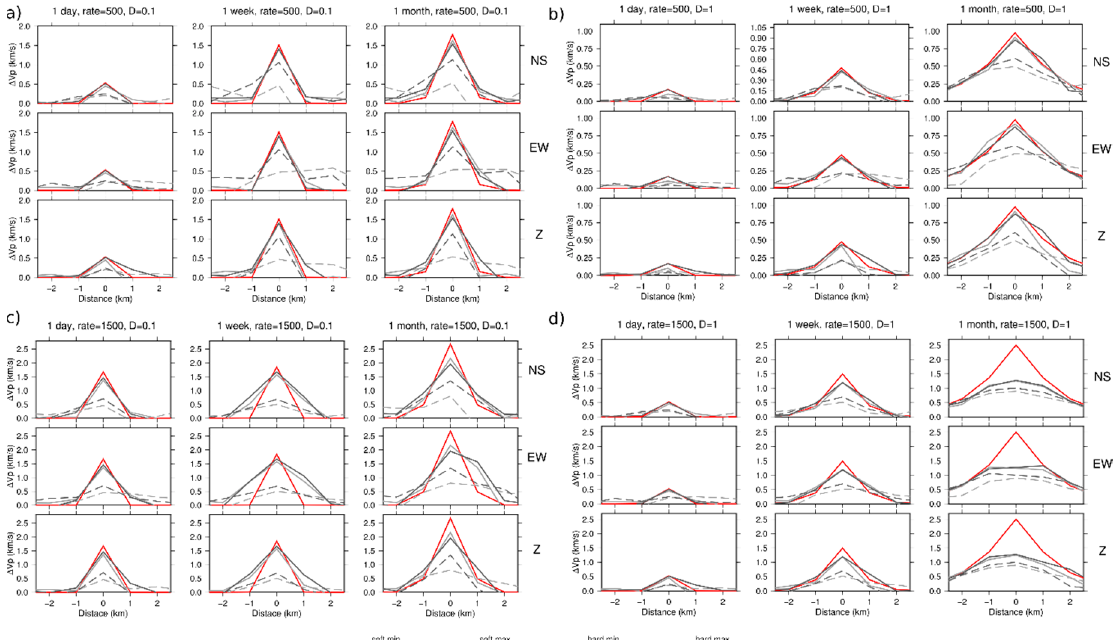
Figure 7. Differences between true (red lines) and retrieved (gray lines) anomalies for all considered cases of rate and diffusivity: rate 500 m 3 /day, D 0.1 m 2 /s ( a ); rate 500 m 3 /day, D 1 m 2 /s ( b ); rate 1500 m 3 /day, D 0.1 m 2 /s ( c ); rate 1500 m 3 /day, D 1 m 2 /s ( d ). The different gray line characteristics indicate the different catalogues: SF MIN (dark solid); SF MAX (dark dashed); HD MIN (light solid); HD MAX (light dashed).